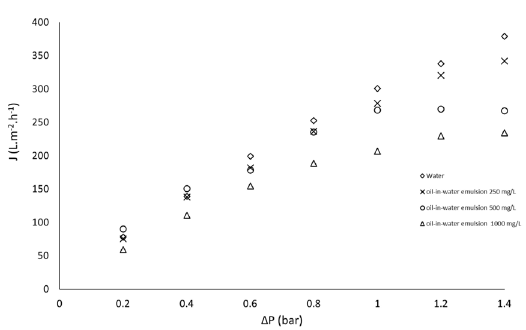
Figure 9. Variation of permeate flux with time at various operating conditions for the M2